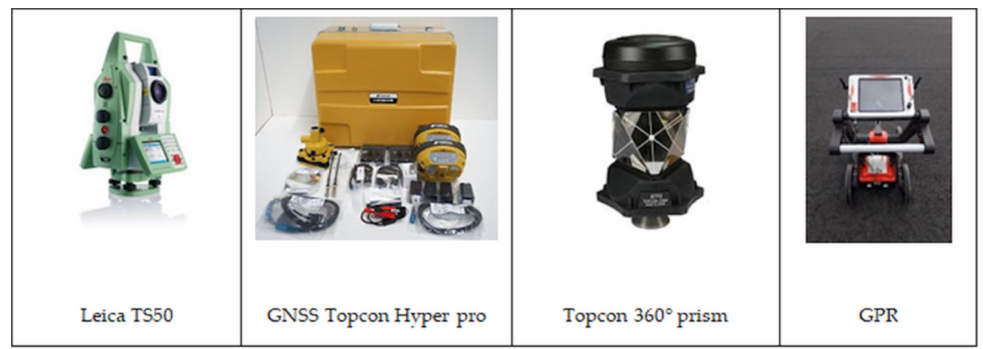
Figure 2. Used measuring